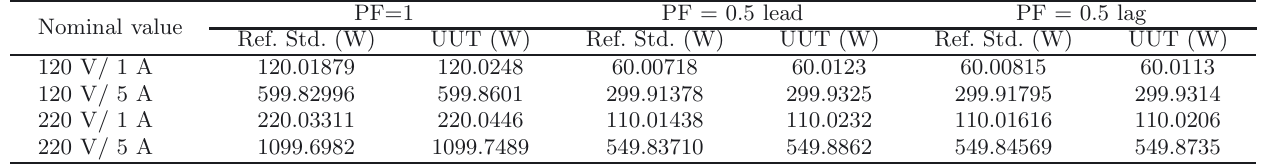
Table 2. Calibration results of the test power meter (RD